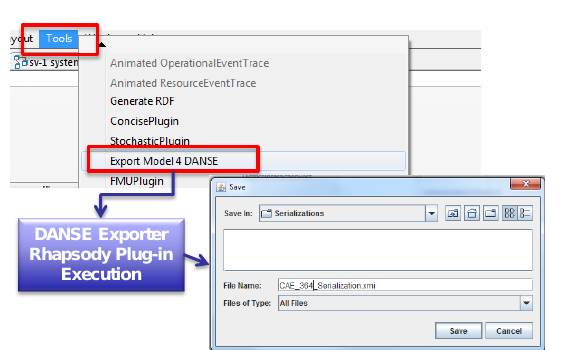
Figure 6. Export to DESYRE of IBM Rhapsody Model Representing the SoS